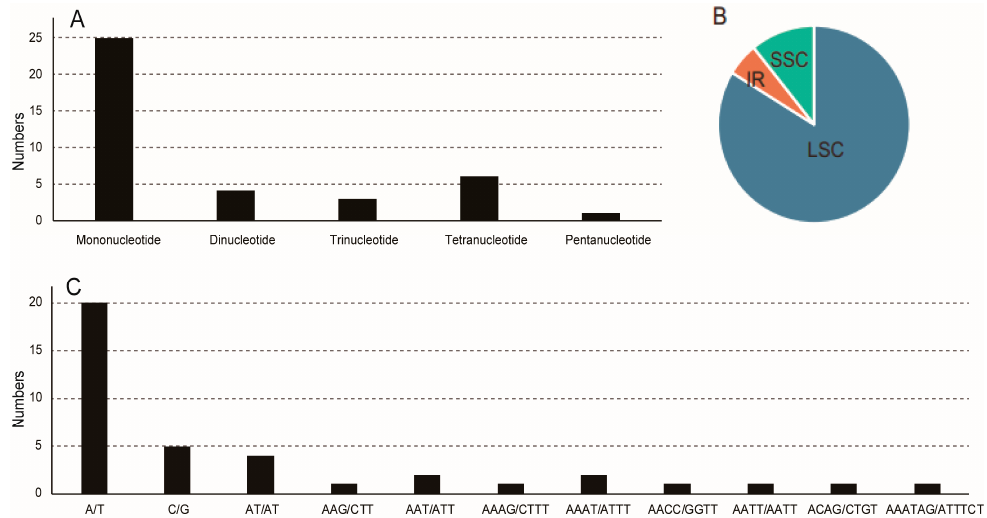
Figure 2. The distribution, type and presence of microsatellites (SSRs) in the chloroplast genome of Scutellaria. baicalensis . ( A ) Number of different SSR types; ( B ) Proportion of SSRs in LSC, SSC, and IR regions; ( C ) Number of identified SSR motifs in different repeat class types.